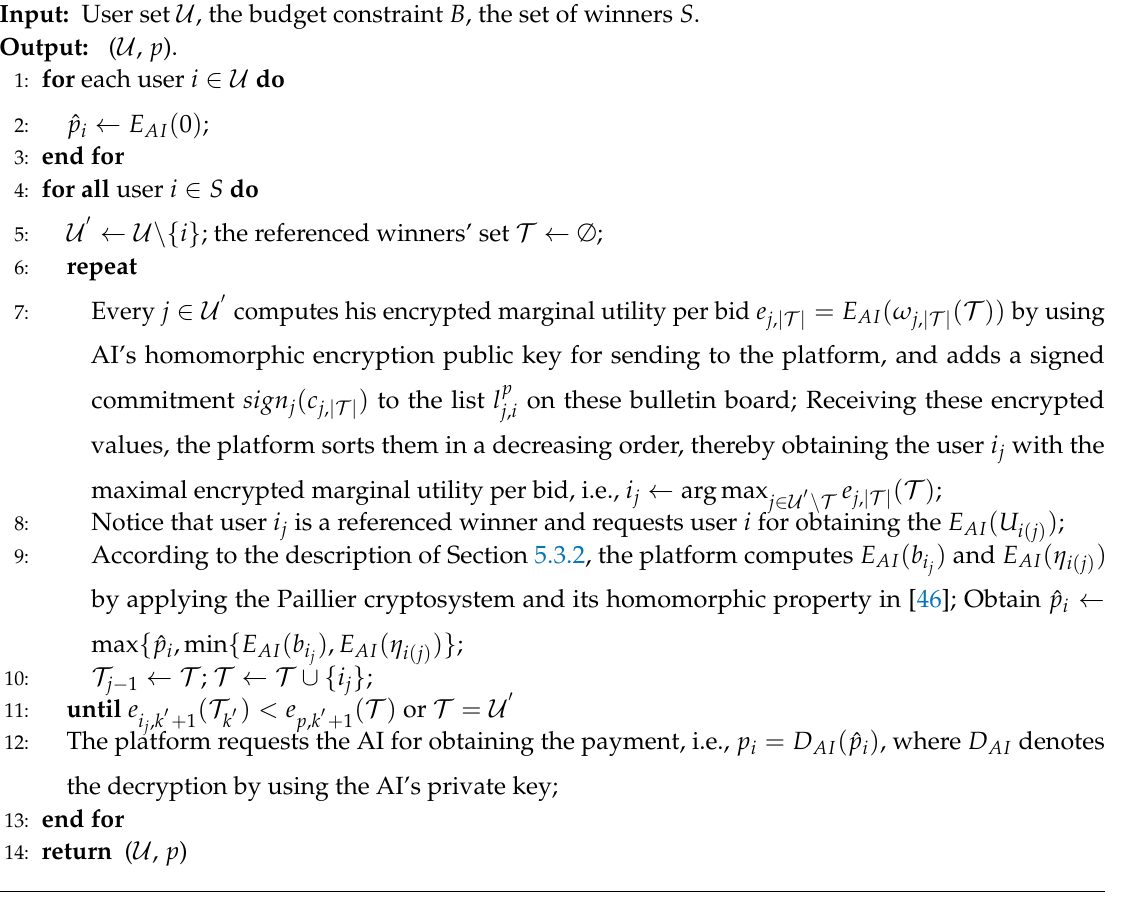
Algorithm 6 Payment Determination for Sensing Submodular